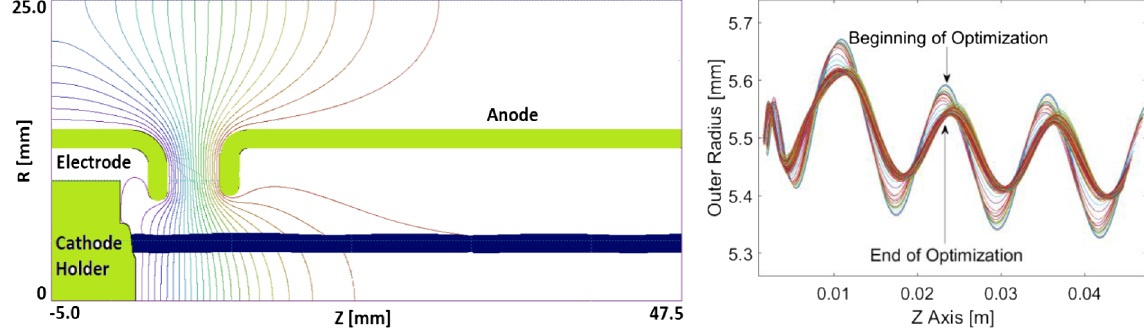
(right).FIG. 2. Simulated hollow cathode geometry (left) and trajectory optimization with simulation